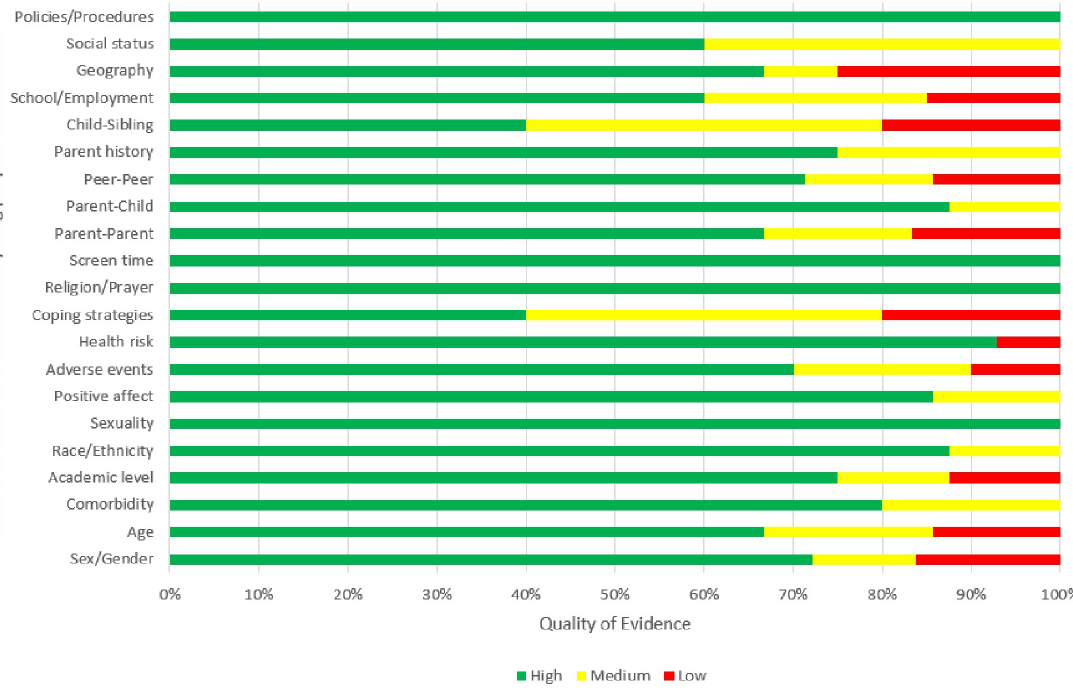
inconsistent evidence and grey represents limited evidence.